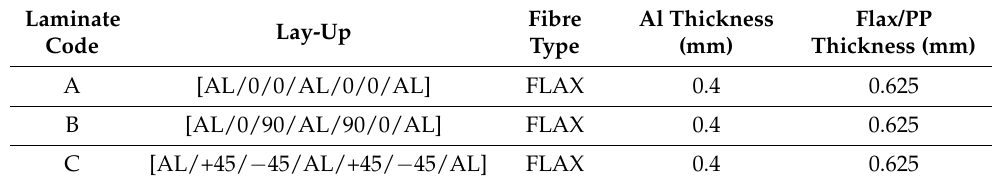
Table 5. Details of fibre metal laminates considered.